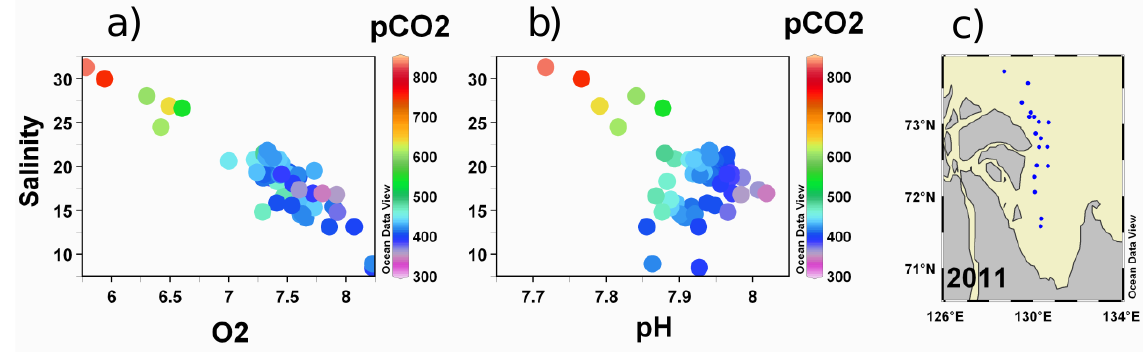
Fig. 13. Plots of CO 2 partial pressure ( p CO 2 , µatm), color-coded by salinity and dissolved oxygen (O 2 , mlL − 1 ) (a) ; p CO 2 color-coded by salinity and pH (b) . Position of transects is shown in (c)